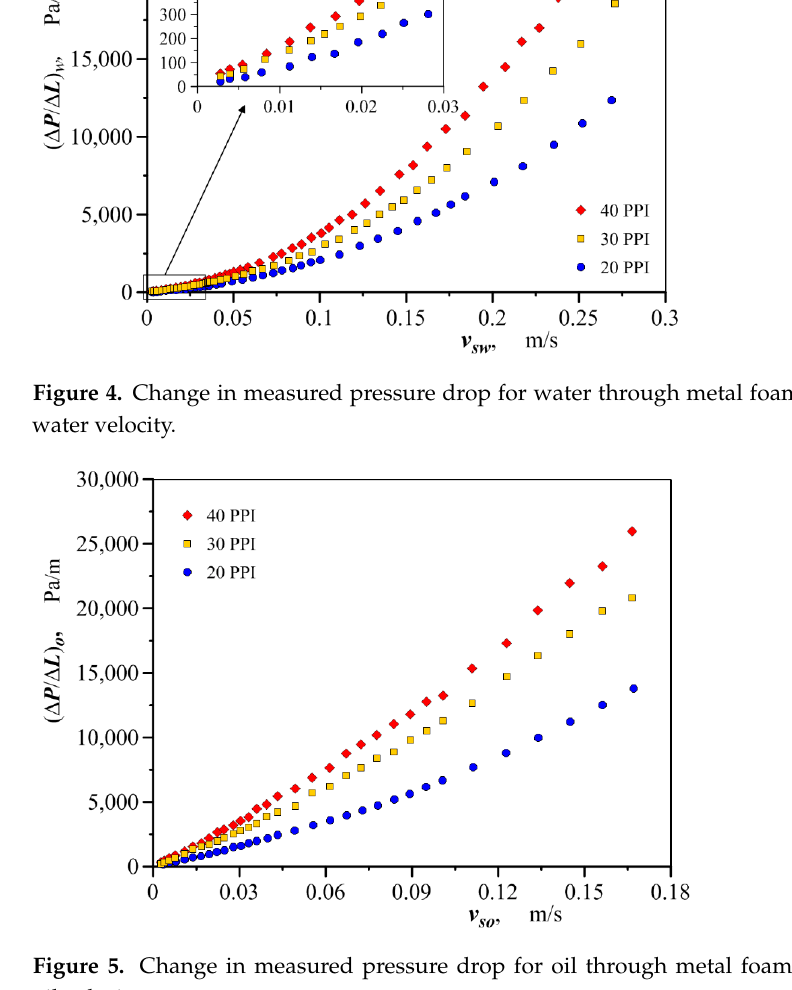
Figure 5. Change in measured pressure drop for oil through metal foams as a function of the oil The laminar flow limit was determined by analysing changes in the friction factor f exp , which was determined according to relation (4), based on the measured pressure drop ( Δ P/ Δ L) exp and the Darcy-Weisbach equation,